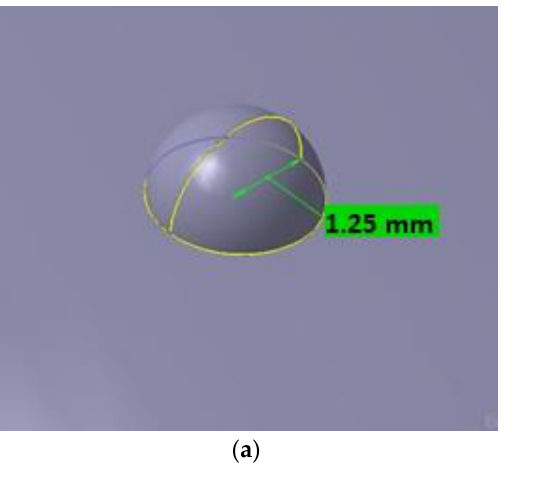
Figure 4. CAD design of the ( a ) bump with a diameter of 2.5 mm and ( b ) dimple with a diameter of 2.5